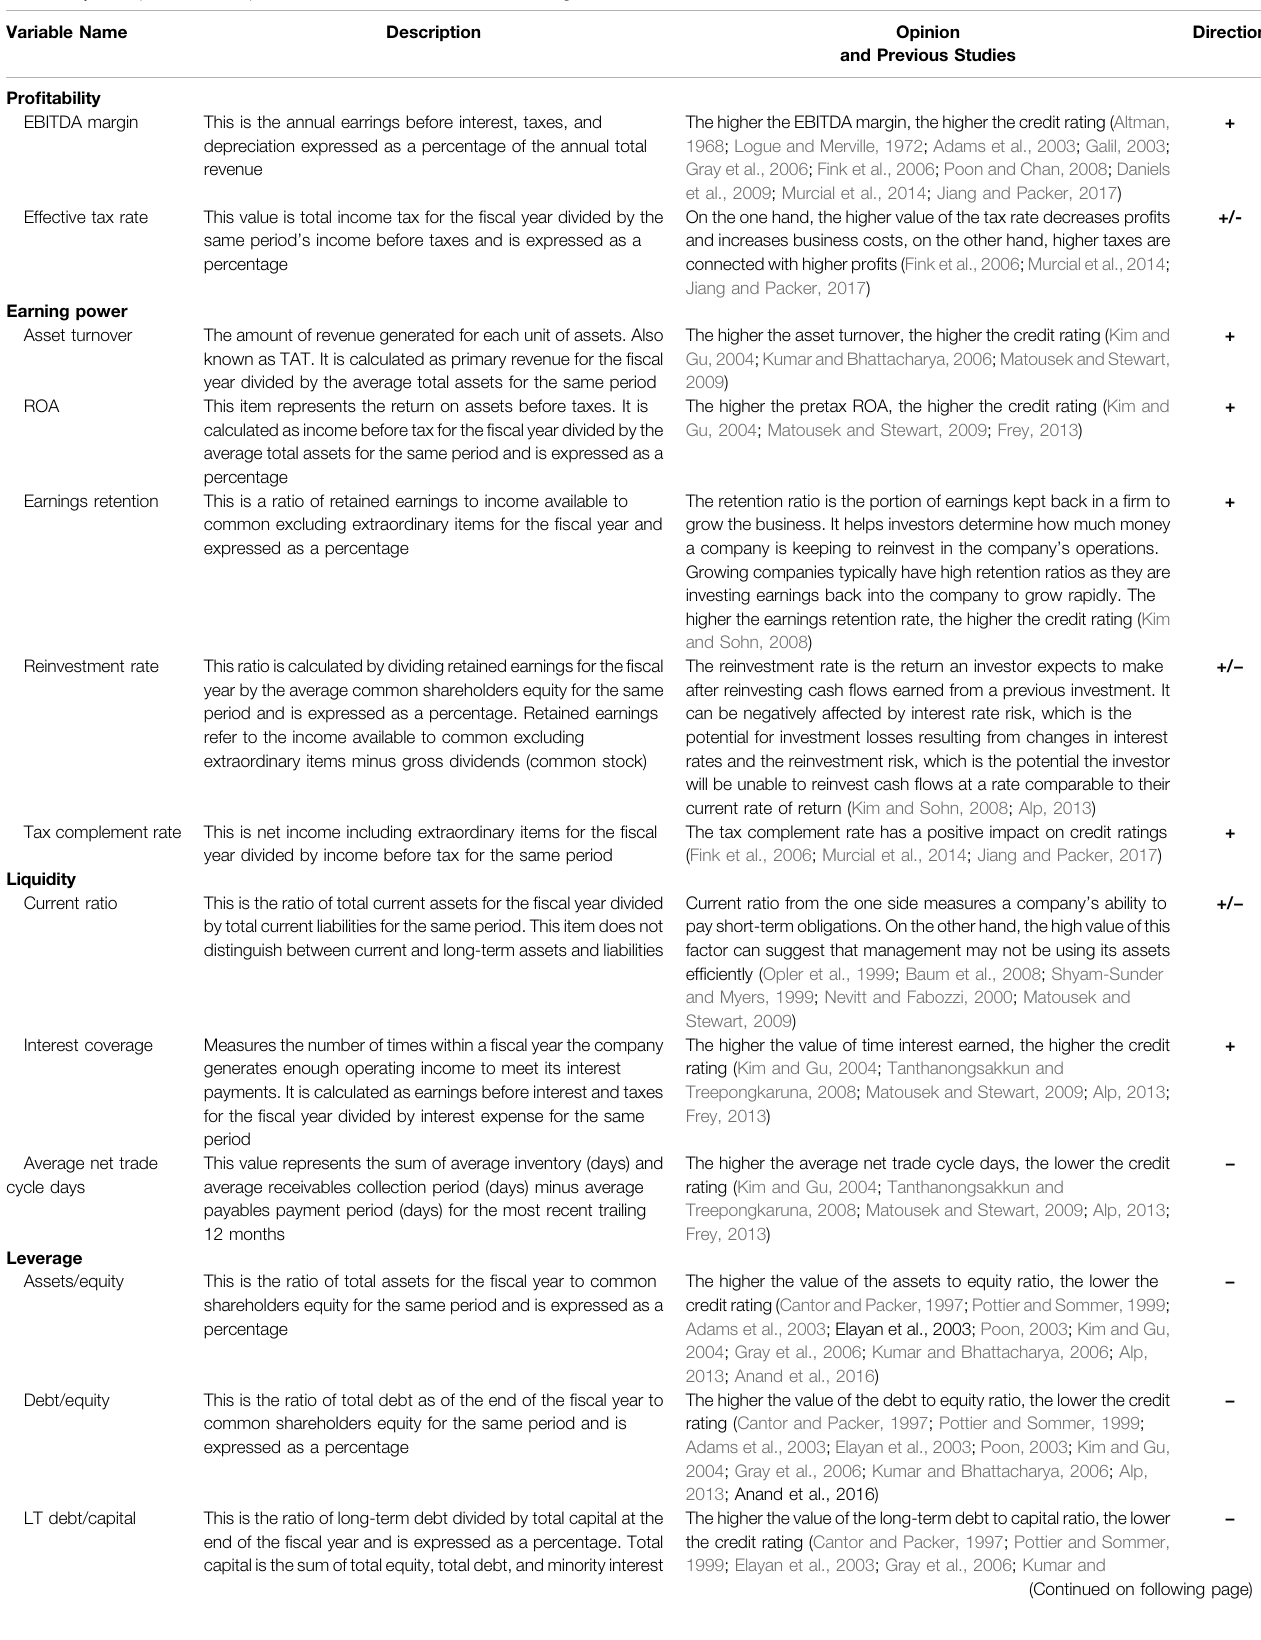
TABLE 4 | Description of the impact of the fi nancial factors on credit